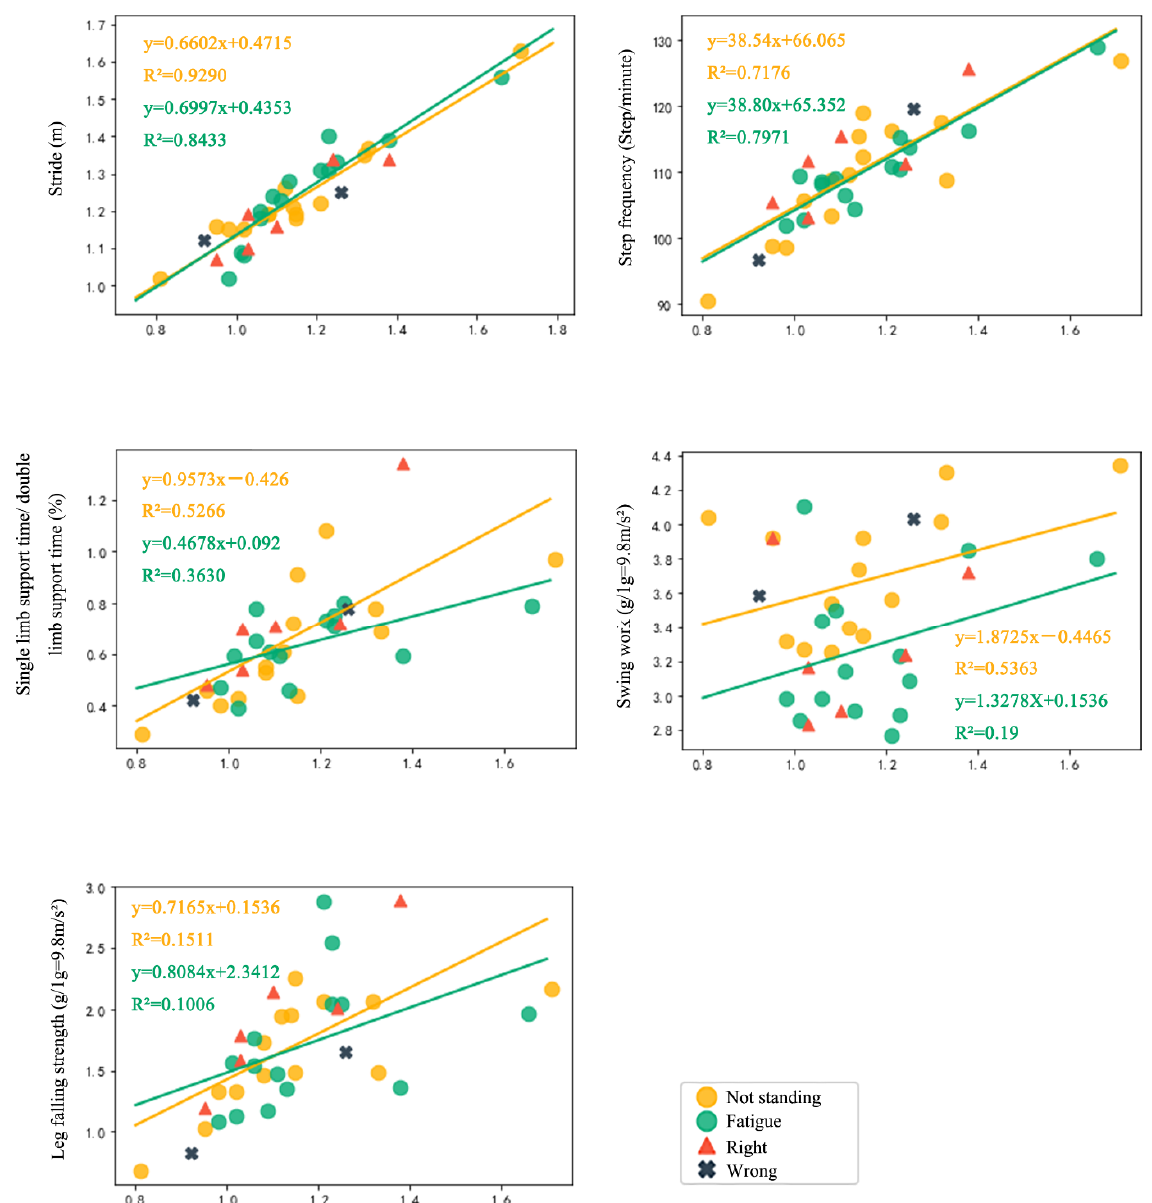
Figure 7. Superposition of walking speed and other gait parameters to fit the linear regression and the accuracy of training.